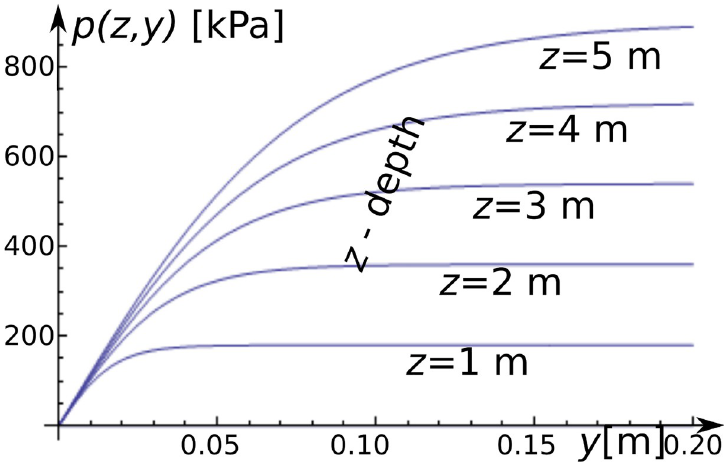
Fig 5. The p-y curves. The horizontal axis is horizontal displacement of segment y [m], and the vertical axis is the soil response [kPa] at a soil depth z = {1, 2, � � � , 5} [m] for the selected curves.